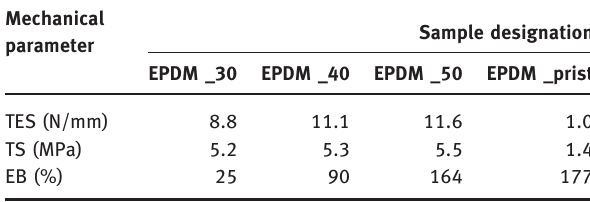
Table 3: Mechanical parameters of vulcanized samples: tear resis-